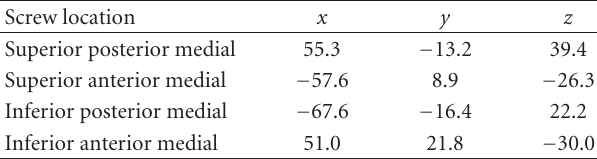
Table 5: Force components (N) applied to the screw implants by the fixation plate in FEA of a fractured and fixated mandible. The x -direction is along the length of the mandible, y is normal to the bone plane, and the z -direction is their cross